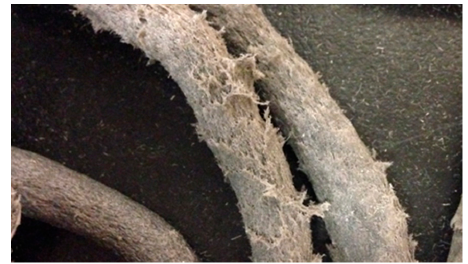
Figure 2. Hemp/polypropylene composite (20 wt %) extruded though a 10 mm die.